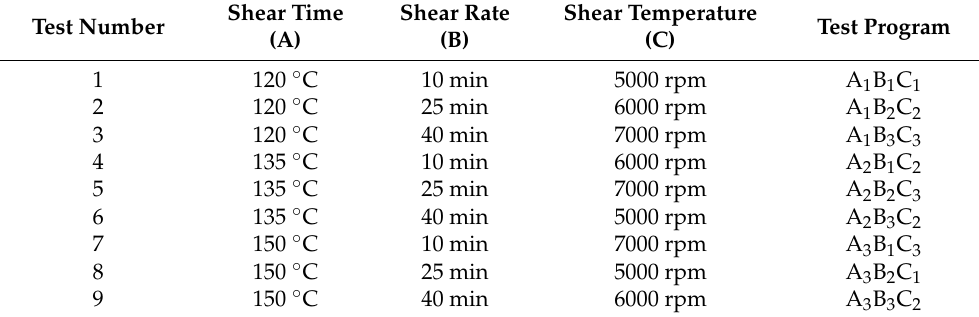
Table 4. Orthogonal test